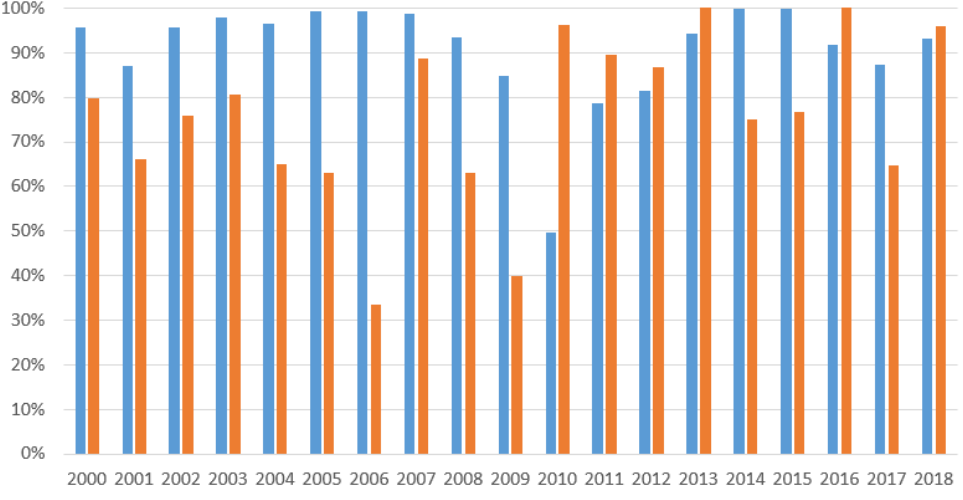
Figure 1. Proportion of major disaster-causing factors in direct economic losses and human losses from marine disasters in